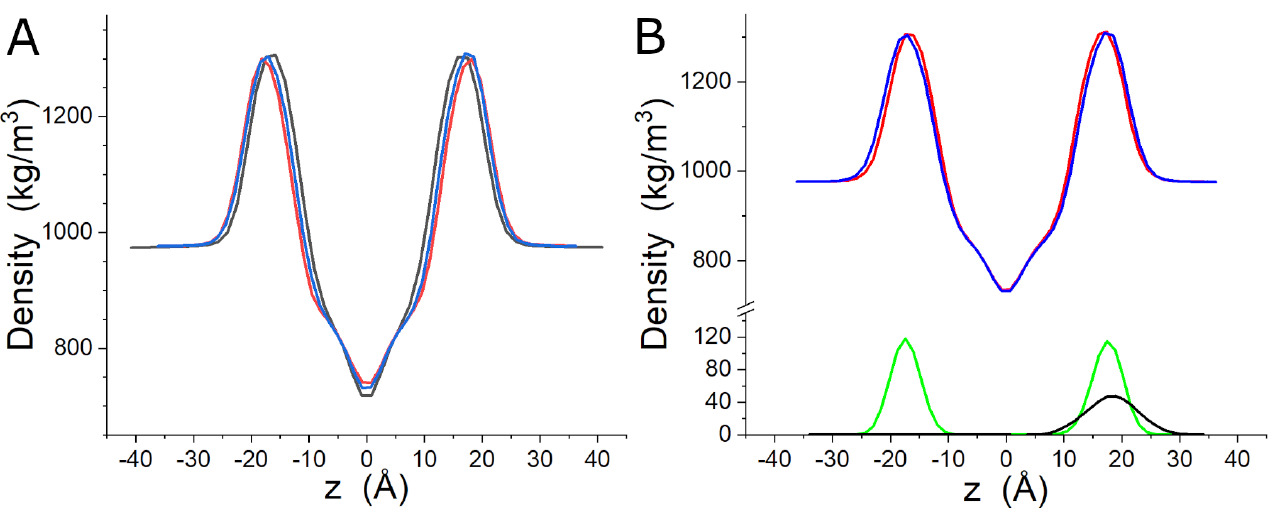
Figure 4. Bilayer density profiles derived from MD simulations for the peptide-free bilayers ( A ) and the Lipid-3 and gp41rk/Lipid-3 bilayers ( B ). In ( A ), the curves are Lipid-1 (black), Lipid-2 (red) and Lipid-3 (blue), while in ( B ), the curves are Lipid-3 (blue), gp41rk/Lipid-3 (red), the lipid P atoms (green) and gp41rk